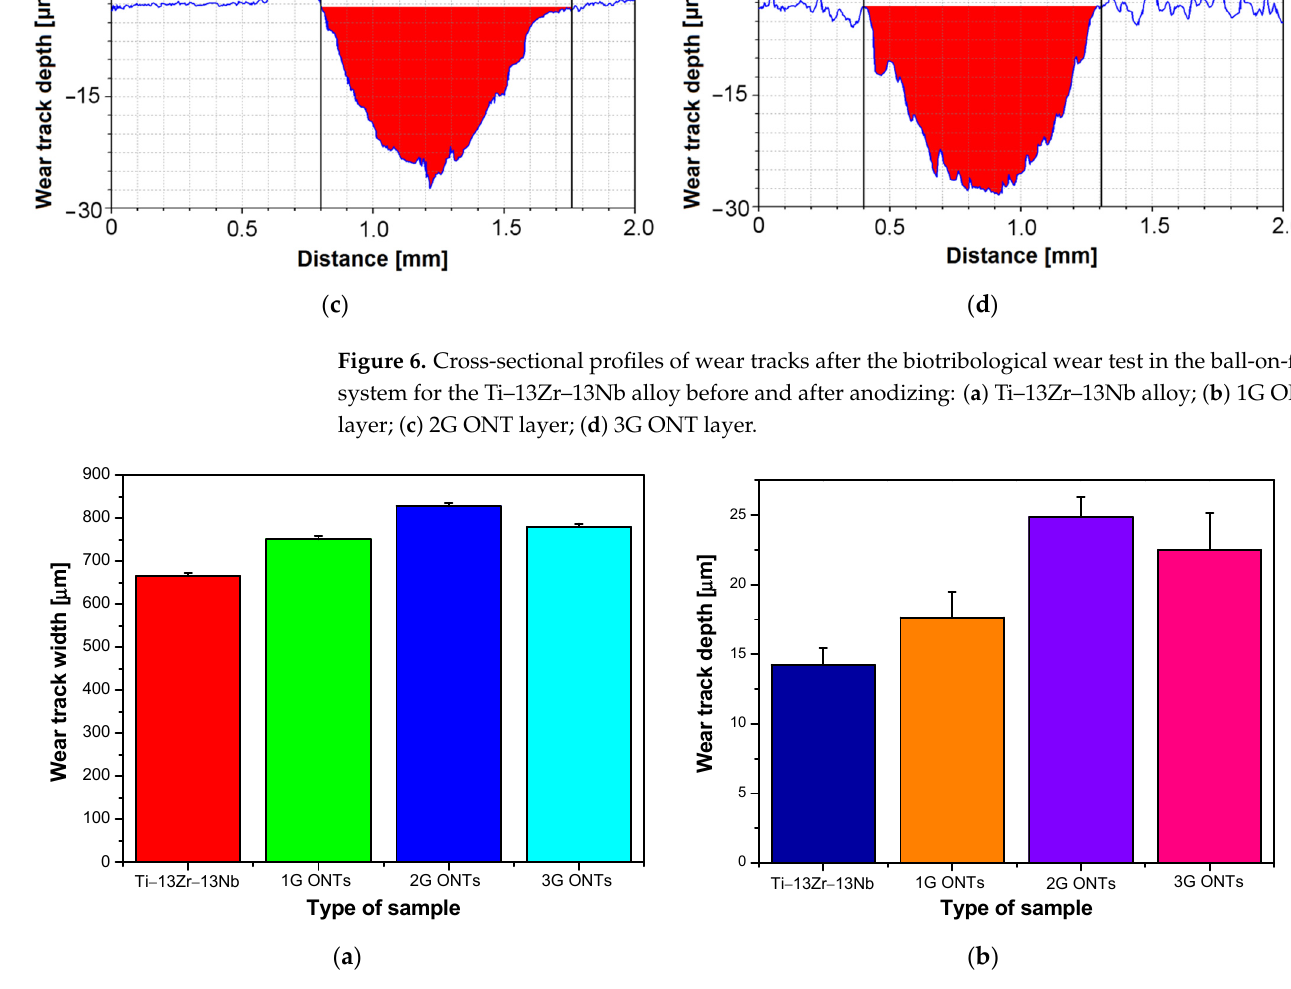
Figure 7. Parameters obtained after the biotribological wear test in the ball-on-flat system for the Ti–13Zr–13Nb alloy before and after anodizing: ( a ) wear track width; ( b ) wear track depth. Based on the d av parameter (Figure 5a), which strongly depends on the type of